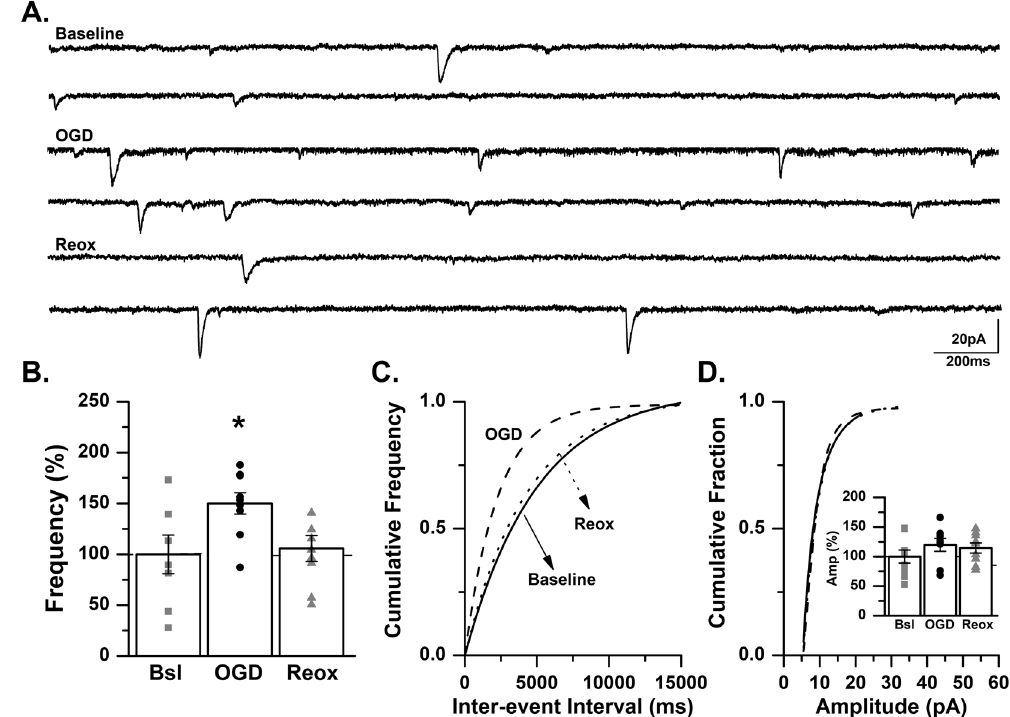
Figure 7. mEPSC frequency is significantly increased in CA3 pyramidal cells during OGD. ( A ) Representative traces from a control C57BL/6 mouse recorded at baseline, during OGD and during reoxygenation (reox) demonstrating an increase in mEPSC frequency during OGD. ( B ) Averaged data demonstrating that mEPSC frequency is significantly increased during OGD and returns to baseline levels during reox as a percent of baseline ( n = 9 cells, 7 animals; baseline, Bsl: 0.5 ± 0.1 Hz; OGD: 0.72 ± 0.14 Hz; reox: 0.45 ± 0.06 Hz). * p < 0.05, K-W ANOVA. Data presented as percent mean ± SEM. ( C ) Representative inter-event cumulative frequency histogram demonstrating a reduction in the inter-event interval during OGD. ( D ) Representative amplitude cumulative histogram demonstrating no change in mEPSC amplitude during OGD (baseline, Bsl: 14.2 ± 1.58 pA; OGD: 16.14 ± 1.54 pA; reox: 15.8 ± 1.91 pA). Inset showing averaged data for mEPSC amplitude at baseline, during OGD and during reox. Data presented as percent mean ± SEM. Baseline, solid line; OGD, dashed line; reox, dotted